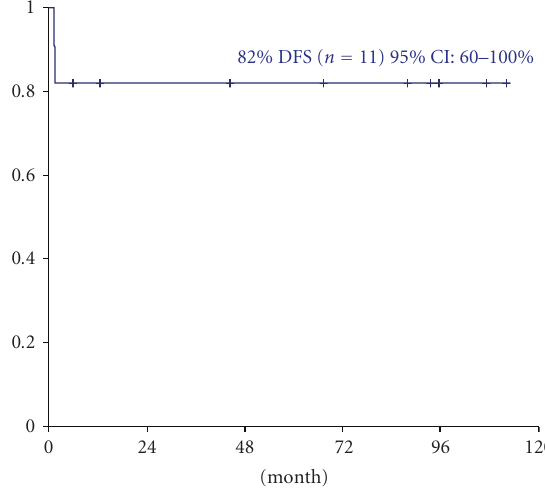
Figure 1: Disease-free survival of APL